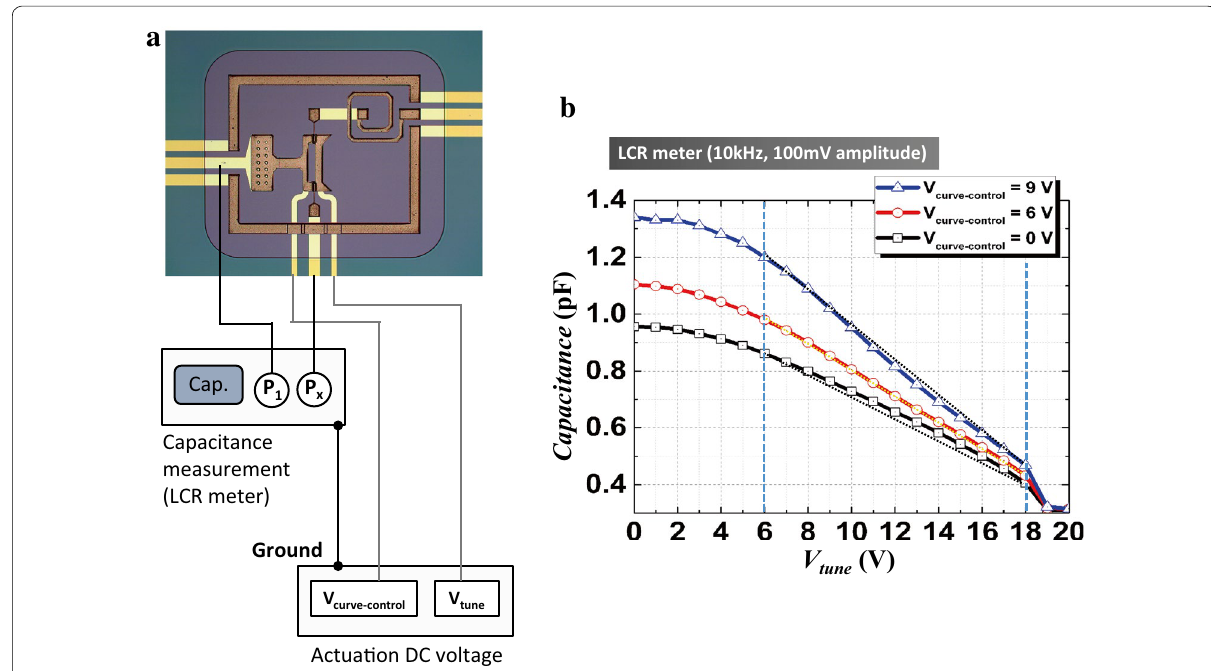
Fig. 6 Capacitance measured results. a Measurement setup. b C–V response of the capacitor device with respect to tuning voltage in several control voltage